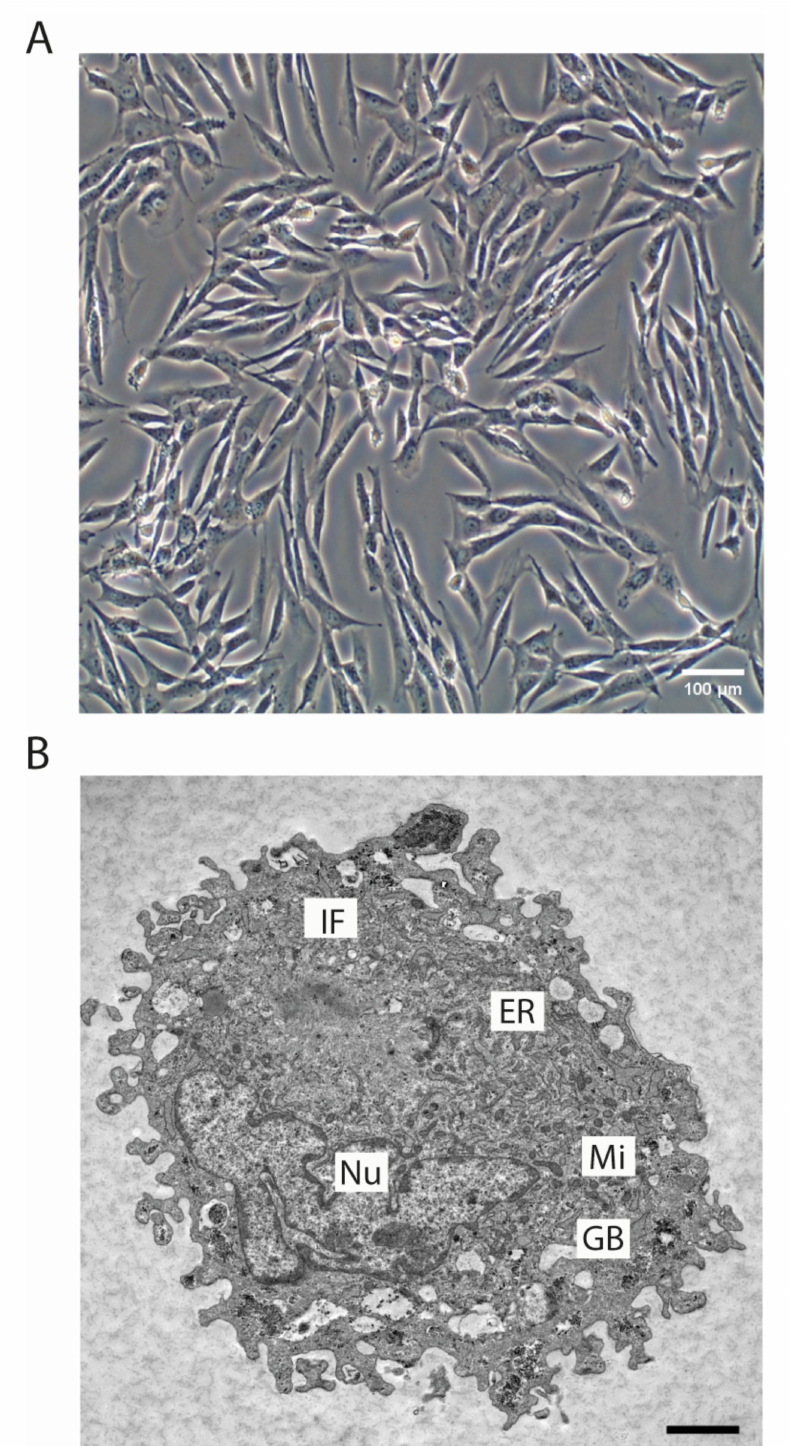
Figure 2. SRH cell line phenotype. ( A ) Phase contrast image of SRH cells in monolayer culture (20 × magnification). ( B ) Transmission electron microscope (TEM) image of a representative SRH cell: Nucleus (Nu), mitochondria (Mi), endoplasmic reticulum (ER), glycogen bodies (GB), intermediate filaments (IF) (scale bar 2 µ